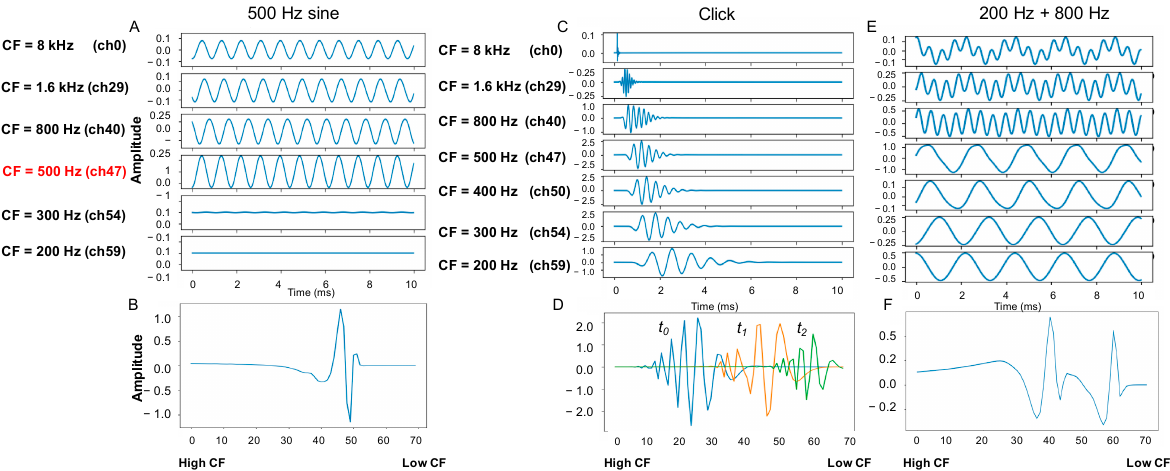
Figure 3. CAR-FAC basilar membrane (BM) response to ( A ) a 500 Hz sine tone at six channels along the travelling wave structure and ( B ) 70-channel response at an instant in time. ( C ) a click (a short and sharp sound) at seven channels along the travelling wave structure and ( D ) 70-channel response at 3 different times. ( E ) a 200 Hz and 800 Hz tone at seven channels along the travelling wave structure and ( F ) 70-channel response at an instant in time.